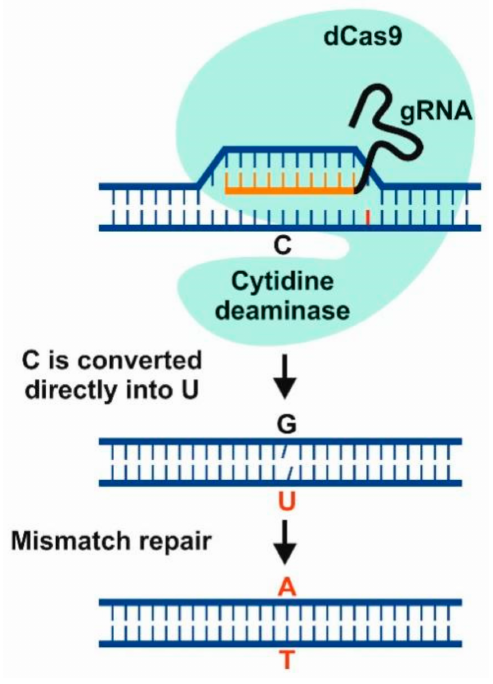
Figure 2. Base editing illustrated with cytidine deamination. In this type of base editing, cytidine deaminase fused with dCas9 targets the desired location. There is no DSB; C is converted directly into U on the free strand; and during mismatch repair, a C → T substitution can be created when the modified strand is used as a template